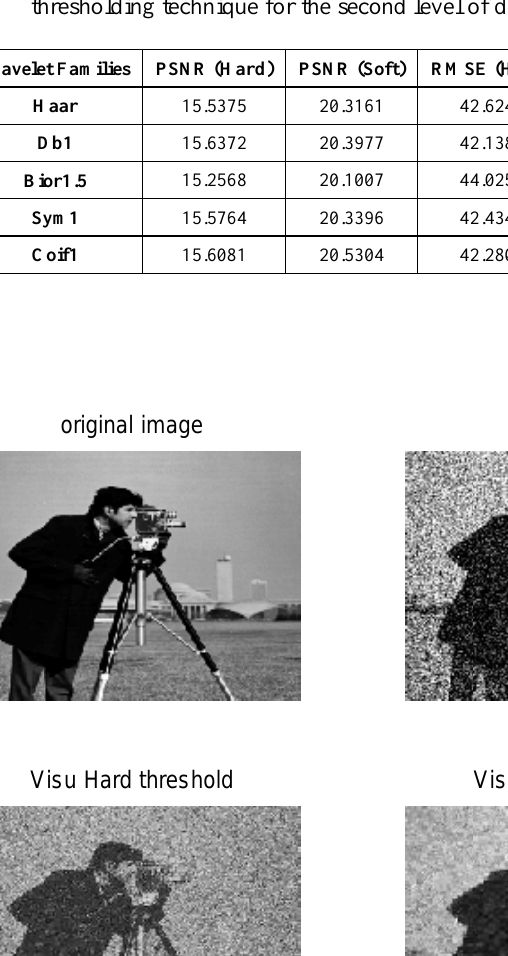
Table 1. PSNR and RMSE value of different wavelet families for noise variance σ = 15 using Visu thresholding technique for the second level of decomposition